Question: Condense the content of this figure into a single sentence.
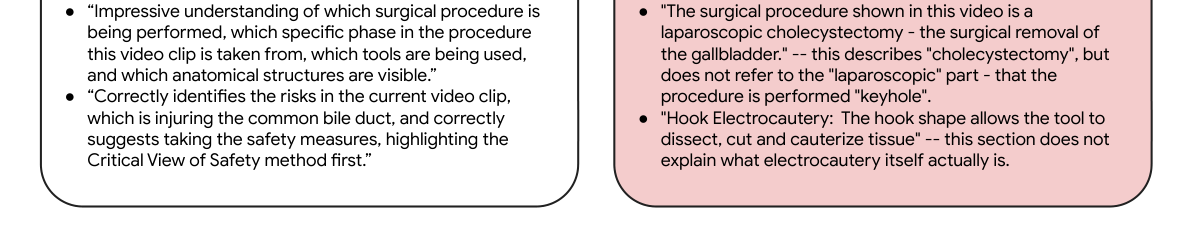
Answer: | Example of Med-Gemini-M 1.5’s long-context capabilities on surgical video dialogue. Med-Gemini-M 1.5 analyzes a video clip from the Cholec80 dataset comprising footage from a laparoscopic cholecystectomy (a keyhole operation to remove the gallbladder). The model demonstrates its ability to analyse the video and conduct a realistic dialogue with a student learning about the procedure.